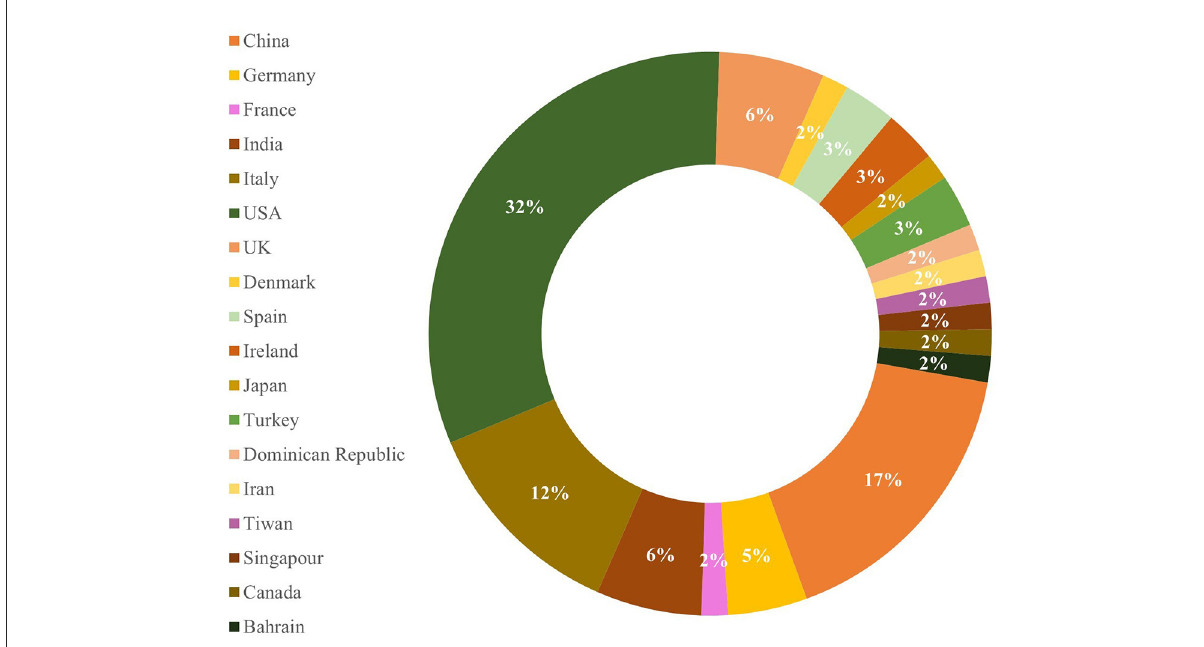
FIGURE2 Distribution of the reviewed studies based on country.